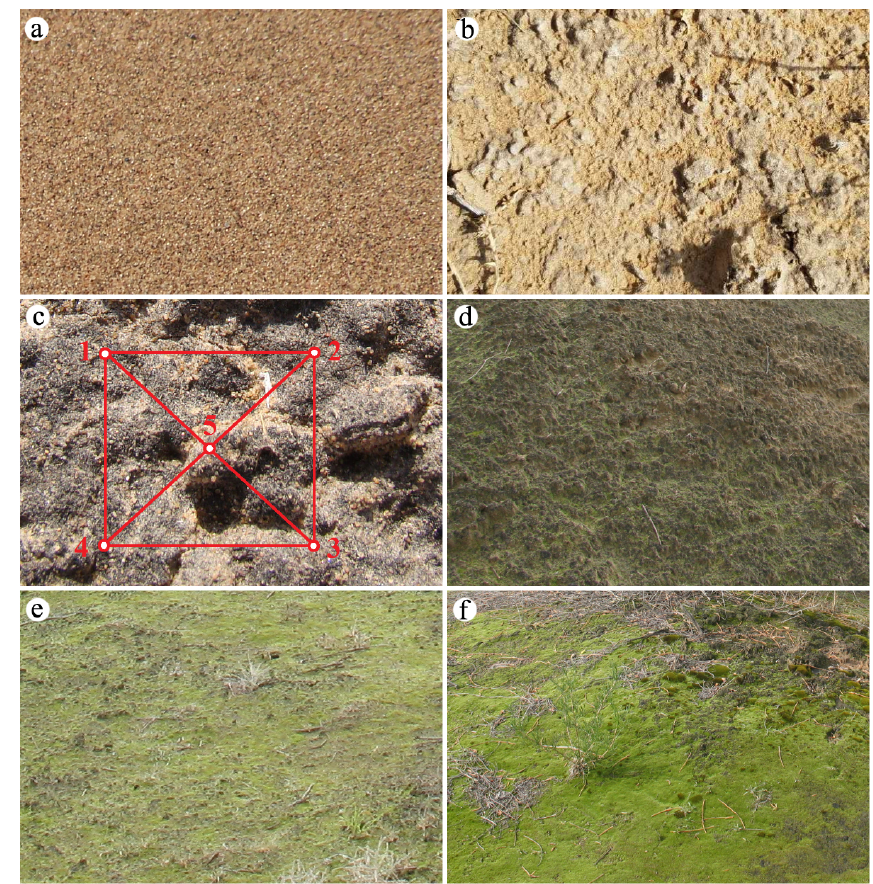
Figure 1. Sand dune landscape before (MS, a ) and after establishing sand-binding vegetation with physical crusts dominated by few algae, revegetated in 2010 (5YR, b ); with BSCs dominated by algae and lichens, revegetated in 2000 (15YR, c ); with BSCs dominated by lichens and few mosses, revegetated in 1987 (28YR, d ); with BSCs dominated by few lichens and mosses, revegetated in 1981 (34YR, e ); and with BSCs dominated by mosses, revegetated in 1964 (51YR, f ). Five soil cores (3.5cm diameter) with crust layers from four vertices of a square (20m length) and a diagonal crossing point in each plot were sampled individually (as shown in c